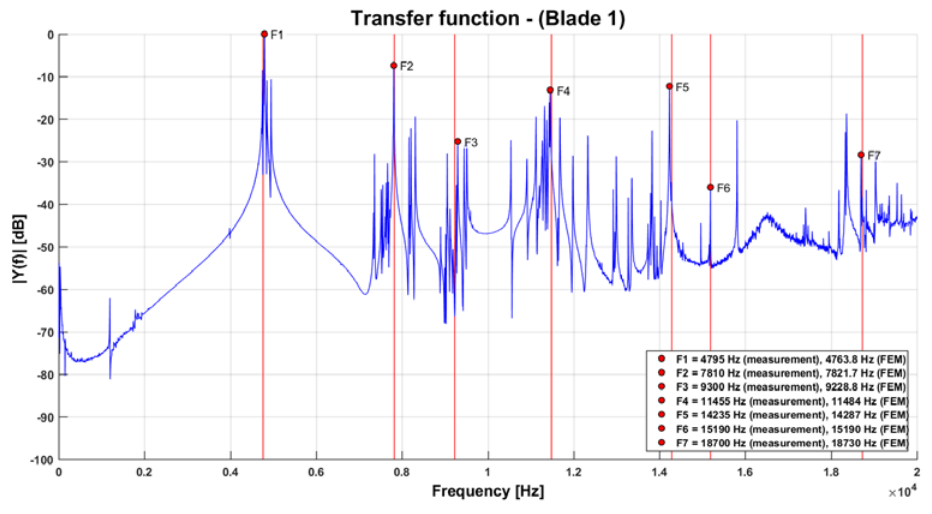
Figure 9. Transfer function and natural frequencies from FE model—without additional masses.